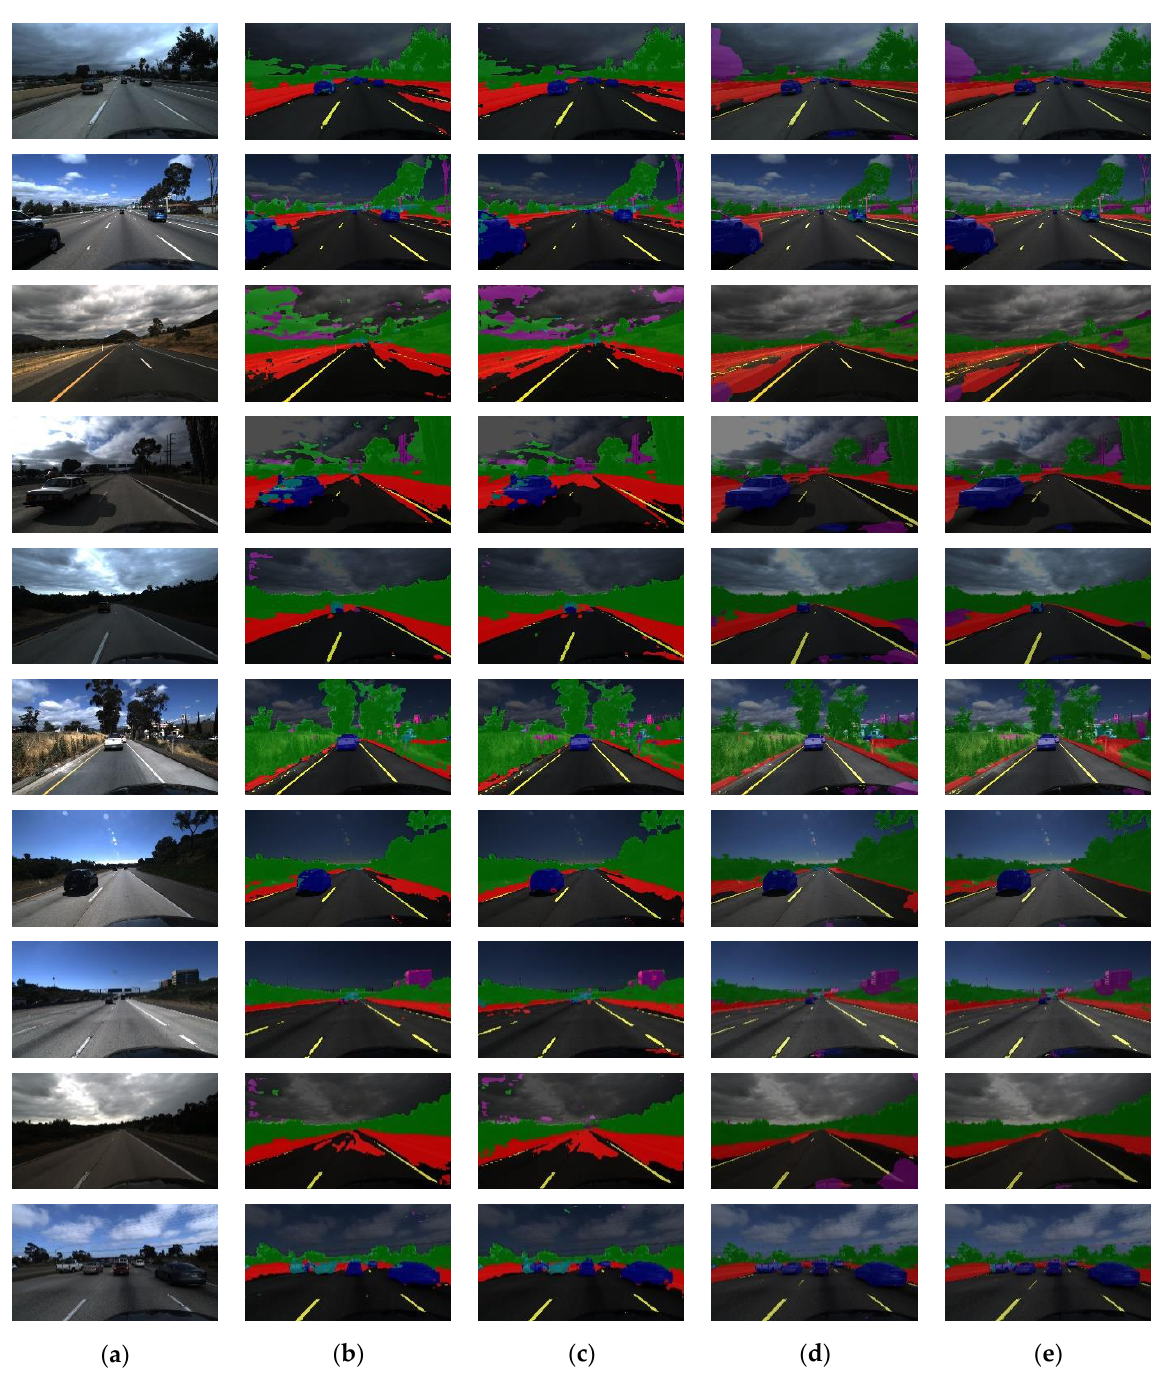
Figure 19. Example results compared with other methods. ( a ) Original images; ( b ) DeepLabv3+; ( c ) PSPNet; ( d ) U-Net; ( e ) Our approach.